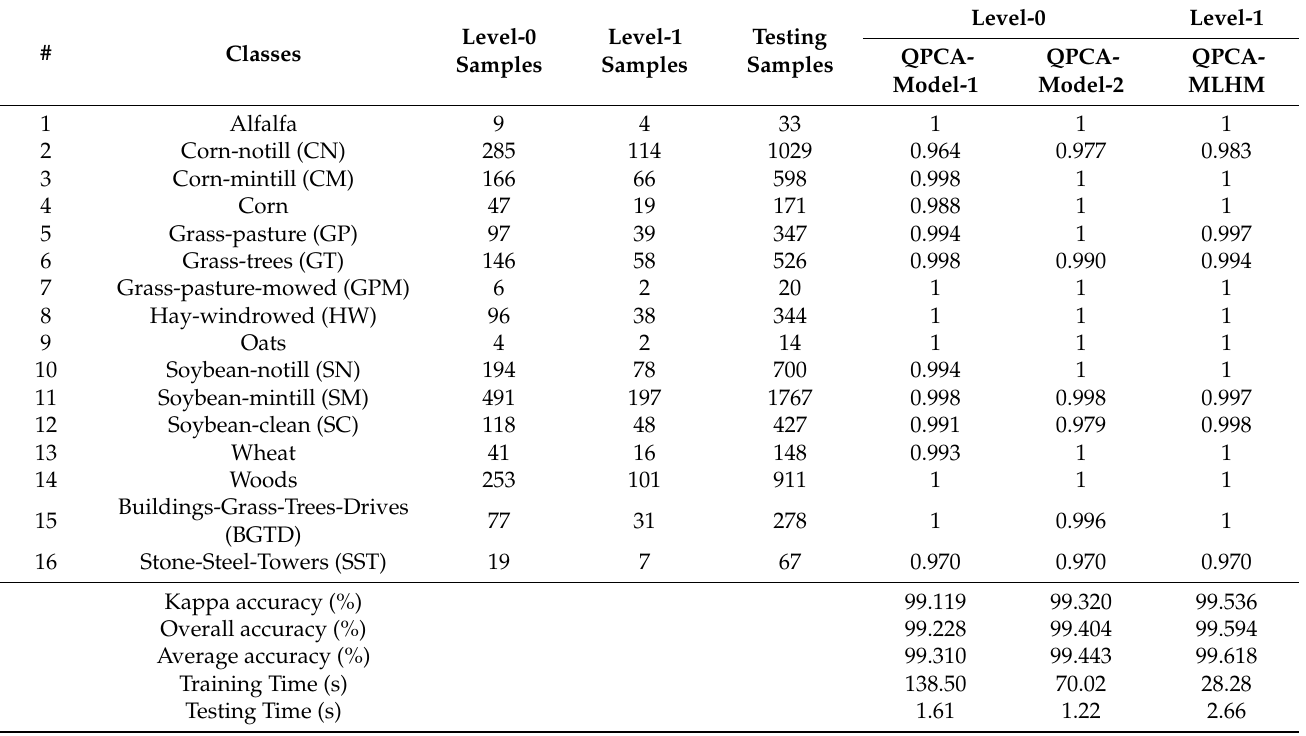
Table 3. The sample number of level-0 and level-1 datasets. It also indicates the results of the two level-0 models and the final results of the level-1 model for the IPs dataset.